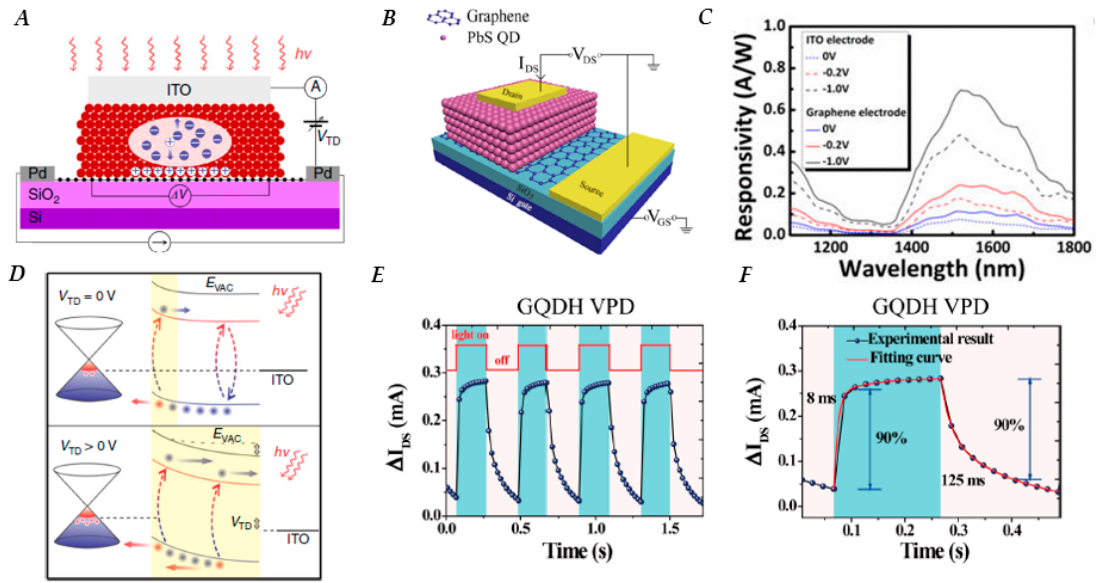
Figure 5. ( A ) Schematic representation of a combined QD photodiode and graphene phototransistor device; V TD creates a bias in the photodiode. ( B ) Schematic of a typical hybrid graphene-QD vertical phototransistor using graphene as an electrode. ( C ) Comparison of responsivity as a function of wavelength at various applied biases for devices using graphene and indium tin oxide (ITO) as an electrode, respectively. ( D ) Energy band diagram of the graphene-QD interface; yellow shading indicates the depletion region in the QD layer. Top schematic is when detector is operated in only phototransistor mode, while the bottom shows the expansion of the depletion region when QD layer is used as a photodiode with an applied bias. ( E ) Photocurrent response of hybrid graphene-PbS QD phototransistor as a function of time for light on/off cycles at an irradiance of 335 mW/cm 2 , ( V DS = 1 V and V GS = 1.5 V). ( F ) Zoomed in view of Figure ( E ) to see rise and decay times of device, rise time 8 ms, decay time 125 ms. Figure ( A , D ) reproduced with permission from [138]. Copyright Springer Nature, 2016. Figure ( B ) reproduced with permission from [141]. Copyright AIP Publishing, 2016. Figure ( C ) reproduced with permission from [140]. Copyright AIP Publishing, 2011. Figure ( E , F ) reproduced with permission from [142]. Copyright American Chemical Society, 2017.